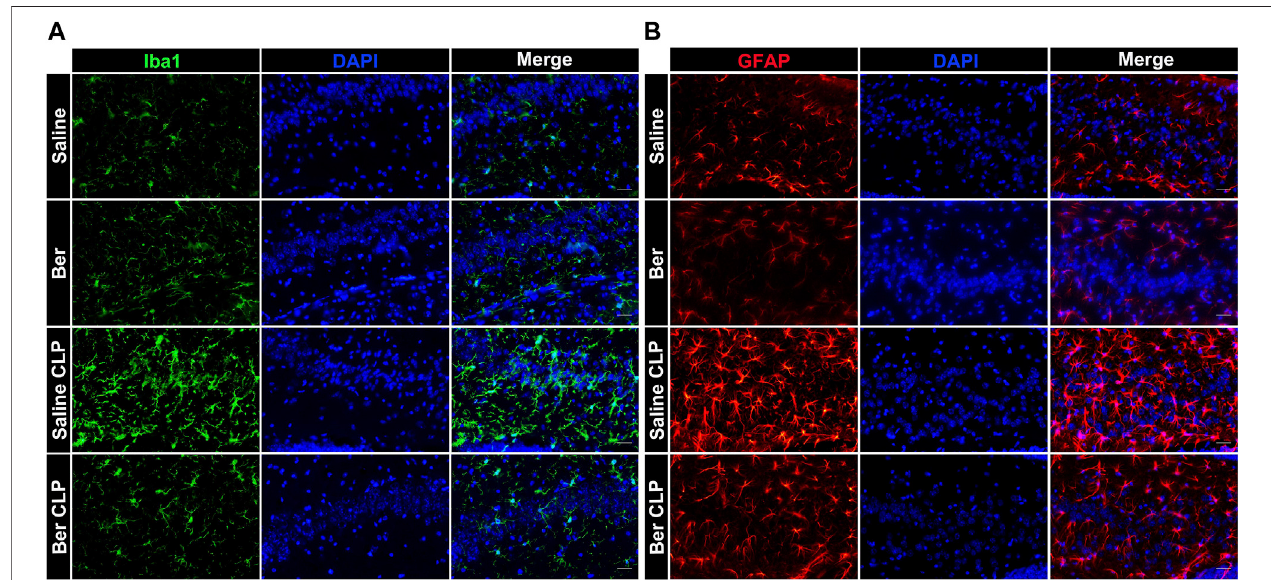
FIGURE 2 | Berberine alleviates activation of microglia and astrocytes in the hippocampus of mice with sepsis. (A, B) . Immuno fl uorescent staining of microglia (Iba1, Green,400 × )andastrocytes (GFAP,Red,400 × )inthehippocampus ofmiceadministratedwithsalineorberberine(10 mg/kg)30 minpriortoachallengeofcecal ligation and puncture (Scale bar (cid:2) 100 μ